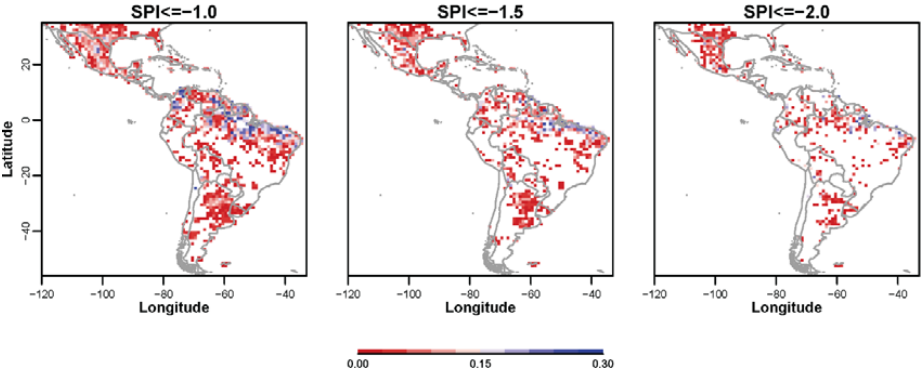
Figure 6. Brier Skill Score (BSS) of the European Centre for Medium Range Weather (ECMWF) S4 SPI-3 forecast for different probabilities of SPI occurrence, at a lead time of 3 months for the hindcast period 1981–2010. Values are indicated in the color bar; land grid points colored in white indicate that the forecasting system is no more skillful than the climatology.